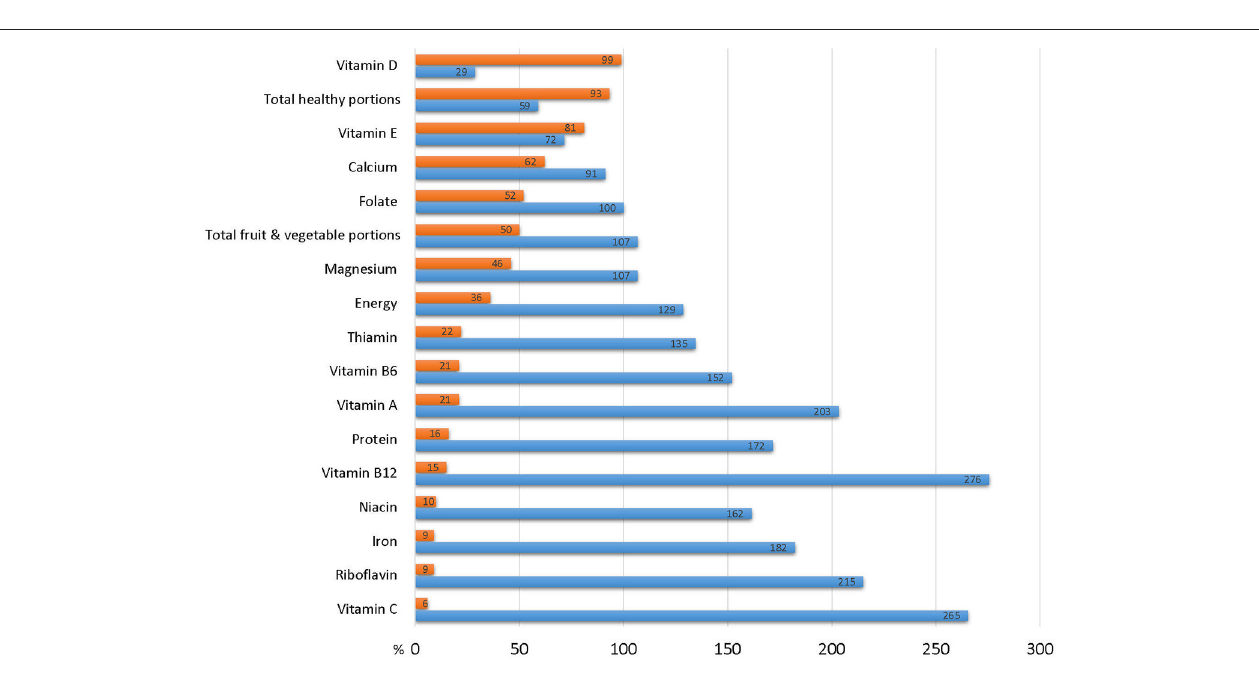
individual diets conform to Israeli government guidelines